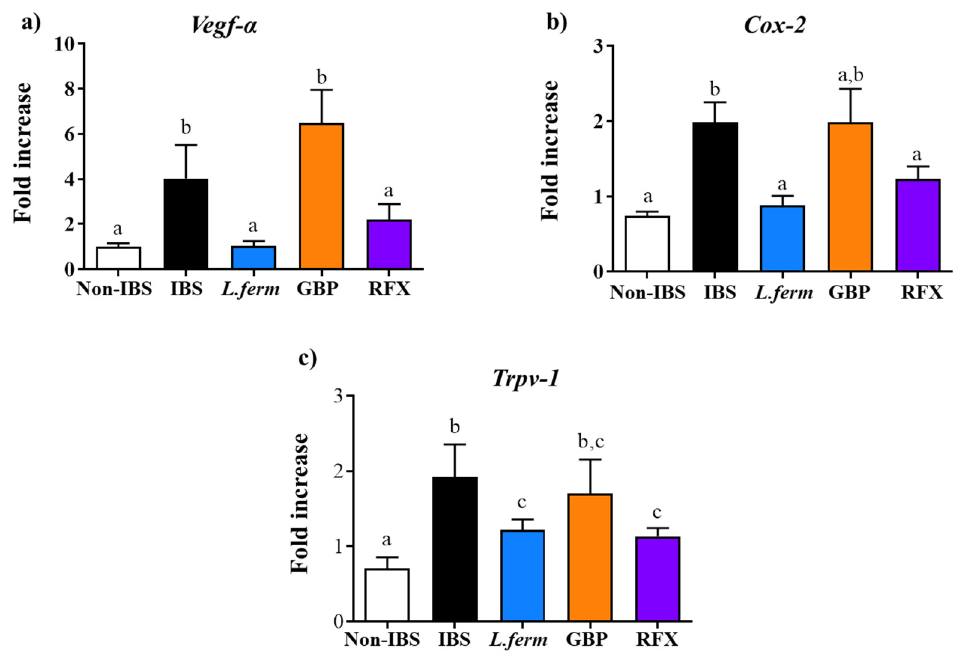
Figure 4. Effect of DCA vehicle (Non-IBS), 4 mmol/L DCA (IBS), L. fermentum (10 9 CFU) ( L. ferm ), Gabapentin at 70 mg/kg (GBP) or Rifaximin at 150 mg/kg (RFX) treatment on colonic gene ex- pression of Vegf- α ( a ), Cox-2 ( b ) and Trpv-1 ( c ) assessed by real-time qPCR and normalized with the housekeeping gene Gapdh . Data are expressed as means ± SEM ( n = 10). Groups with different letters statistically differ ( p <